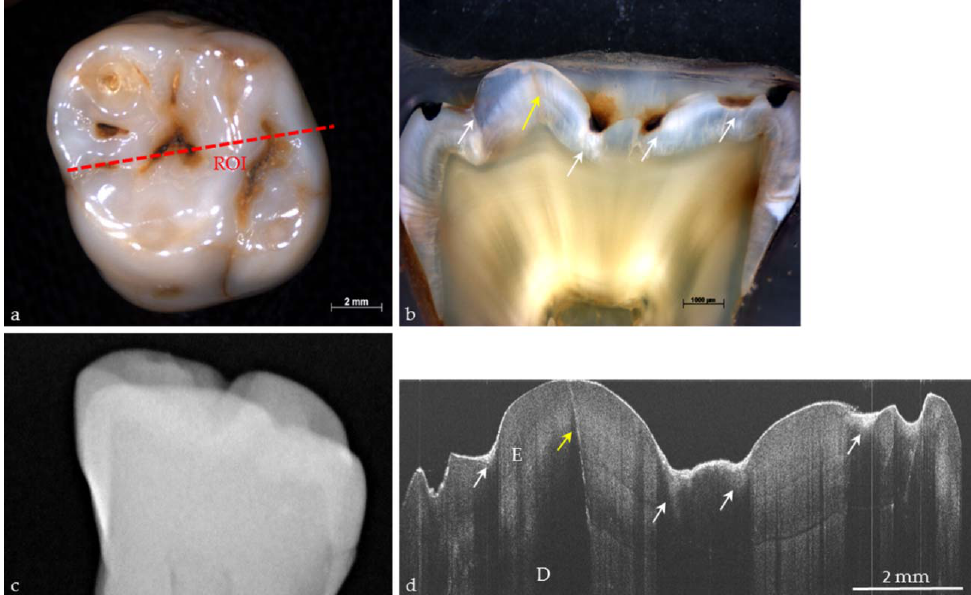
Figure 7. ( a ) Extracted human molar with occlusal caries (ICDAS II Code 2); ( b ) In the histological section through ROI, lesions (white arrows) and enamel cracks (yellow arrows) appear; ( c ) In the conventional digital radiograph no defects or lesions are visible; ( d ) Bright signals in the OCT image of the ROI demonstrate caries lesions (white arrows) and enamel cracking (yellow arrow). E: enamel; D: dentin.